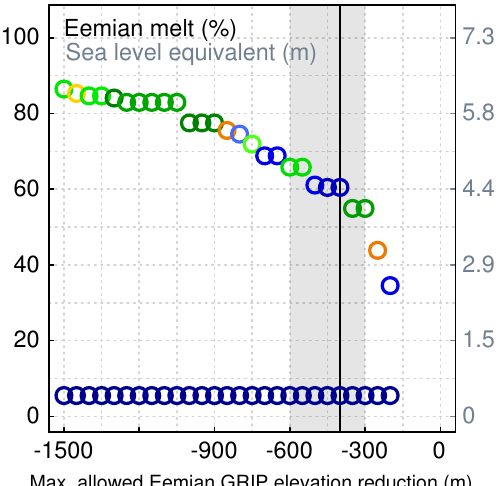
Fig. 10. Sensitivity of the range of Eemian volume loss to the al- lowed Eemian GRIP elevation change. Two circles are shown for each constraint level, representing the minimum and maximum sim- ulations. The color of the circle corresponds to the choice of param- eter c of the simulation that determines the extreme (as described in Fig. 6). No simulation had less than 150m of elevation reduction during the Eemian. The grey band shows the likely range of accept- able constraint values and the vertical black line is the constraint value chosen as default in this study